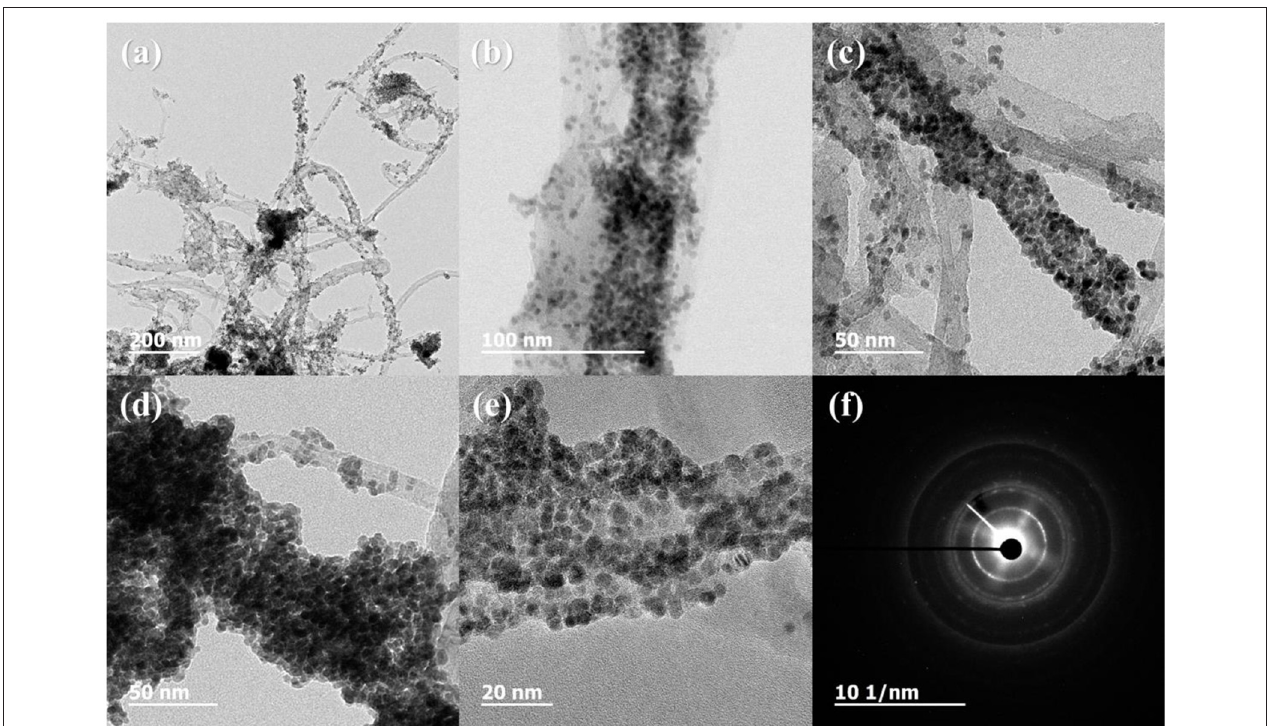
FIGURE 5 | TEM and HR-TEM images and selected area electron diffraction (SAED) pattern of Ni-Pd(P)/MWCNT. (A) 200 nm scale, (B) 100 nm scale, (C,D) 50 nm scale, (E) 20 nm scale, (F) diffraction pattern of Ni-Pd(P)/MWCNT.